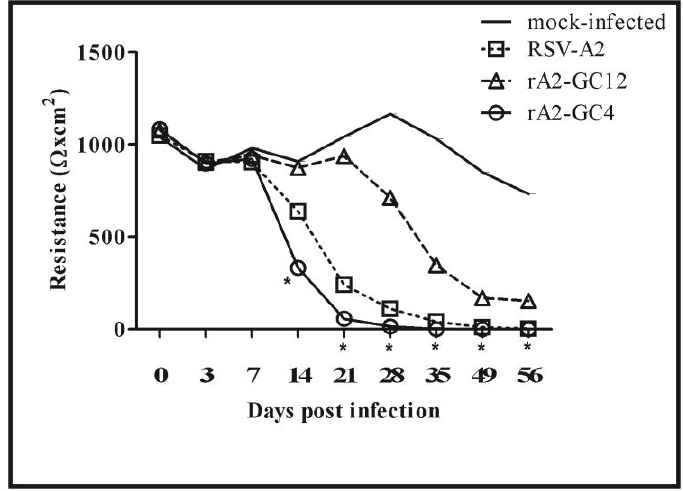
Figure 1. rA2-GC4 infection results in a decline of polarized Calu-3 cells. Data represent the median resistance measurement, Ω × cm 2 , of polarized liquid-covered culture (LCC) Calu-3 cells infected apically with RSVA2, rA2-GC12 or rA2-GC4 at a multiplicity of infection (MOI) of 1 for varying time points. The data presented is representative of one of three independent experiments. * represents significance ( p ≤ 0.05) relative to mock as determined by one-way ANOVA and Bonferroni post hoc comparison of all data at α = 0.05).